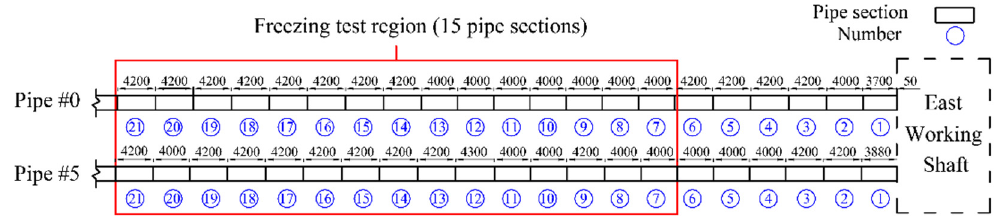
Figure 5. The arrangement of freezing test area in the in-situ test. Figure 5 . The arrangement of freezing test area in the in ‐ situ test. Figure 5 . The arrangement of freezing test area in the in ‐ situ test.